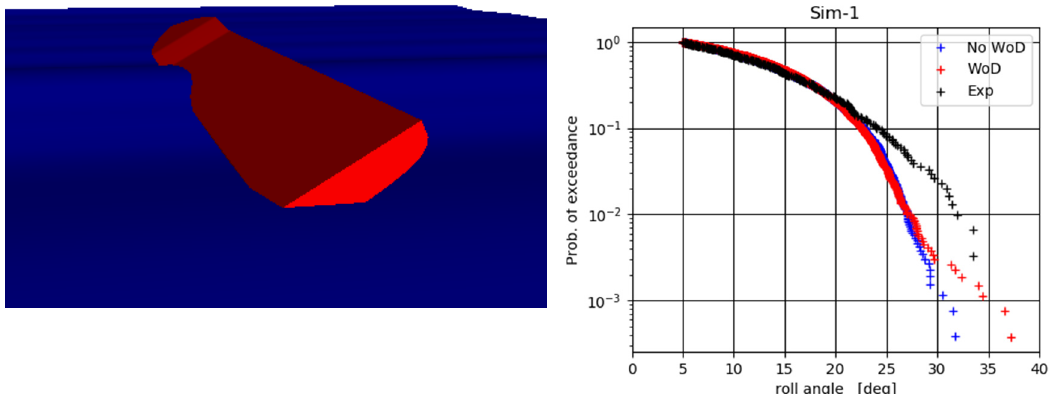
Figure 17. Snapshot from a simulated maximum roll angle with water on the deck ( left ). Probability of exceedance for the values of the positive roll peaks with water on deck in the simulation (WoD) or no water on deck (No WoD) is shown together with the experimental result. The plot is based on 10 realisations of 3 h durations each, condition: following waves, Hs = 4 m, Tp = 13.5 s, Vs ≈ 8 kn.